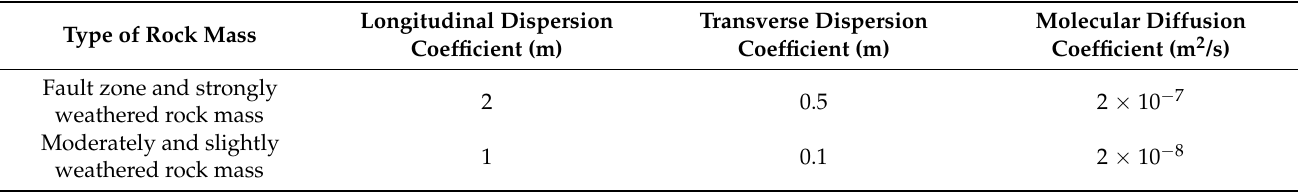
Table 2. Solute transport